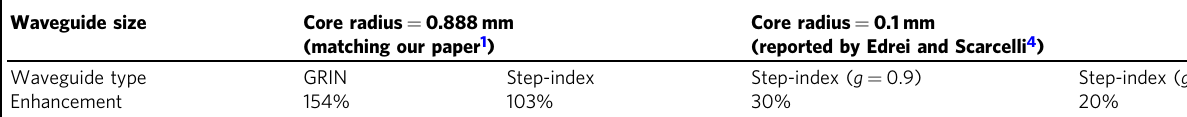
Table 1 Enhancement of penetration depth for different virtual